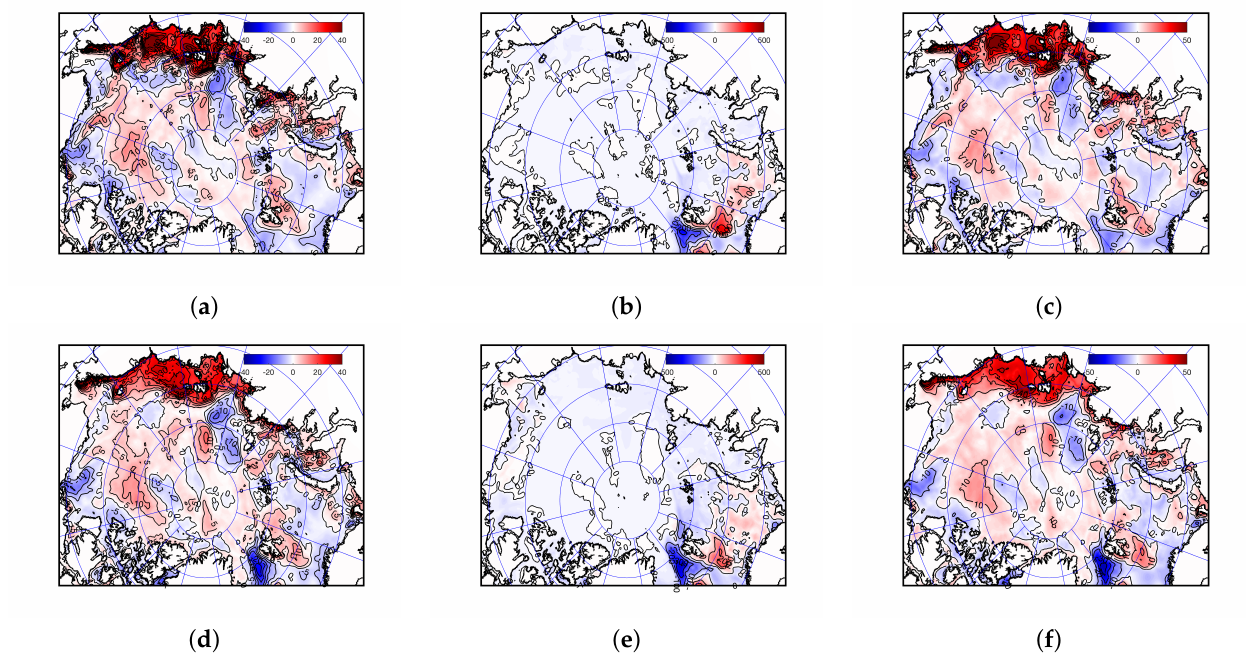
Figure 13. Deviations in ( a , d ) mass of water (kg/m 2 ), ( b , e ) its heat content (MJ/m 2 ), and ( c , f ) mass of salt (kg/m 2 ) per square meter of the Arctic area (above 65 N), obtained as a result of vertical integration from the surface to the 30 m depth and averaged over April–June ( a – c ) and September– November ( d – f ) periods in terms of incremental values in numerical experiment B to experiment